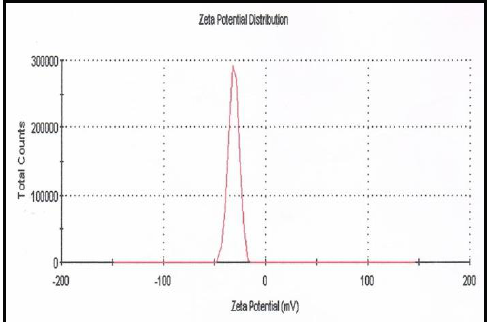
Figure 6: Zeta potential distribution of the F